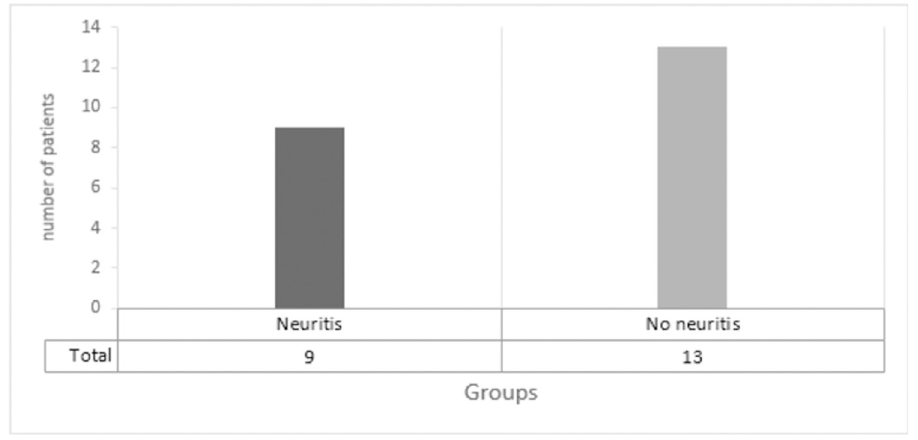
Fig 1. Initial classification of patients with symptoms on the recent ulnar nerve with and without neuritis based on the clinical neurological and electroneuromyography evaluation.